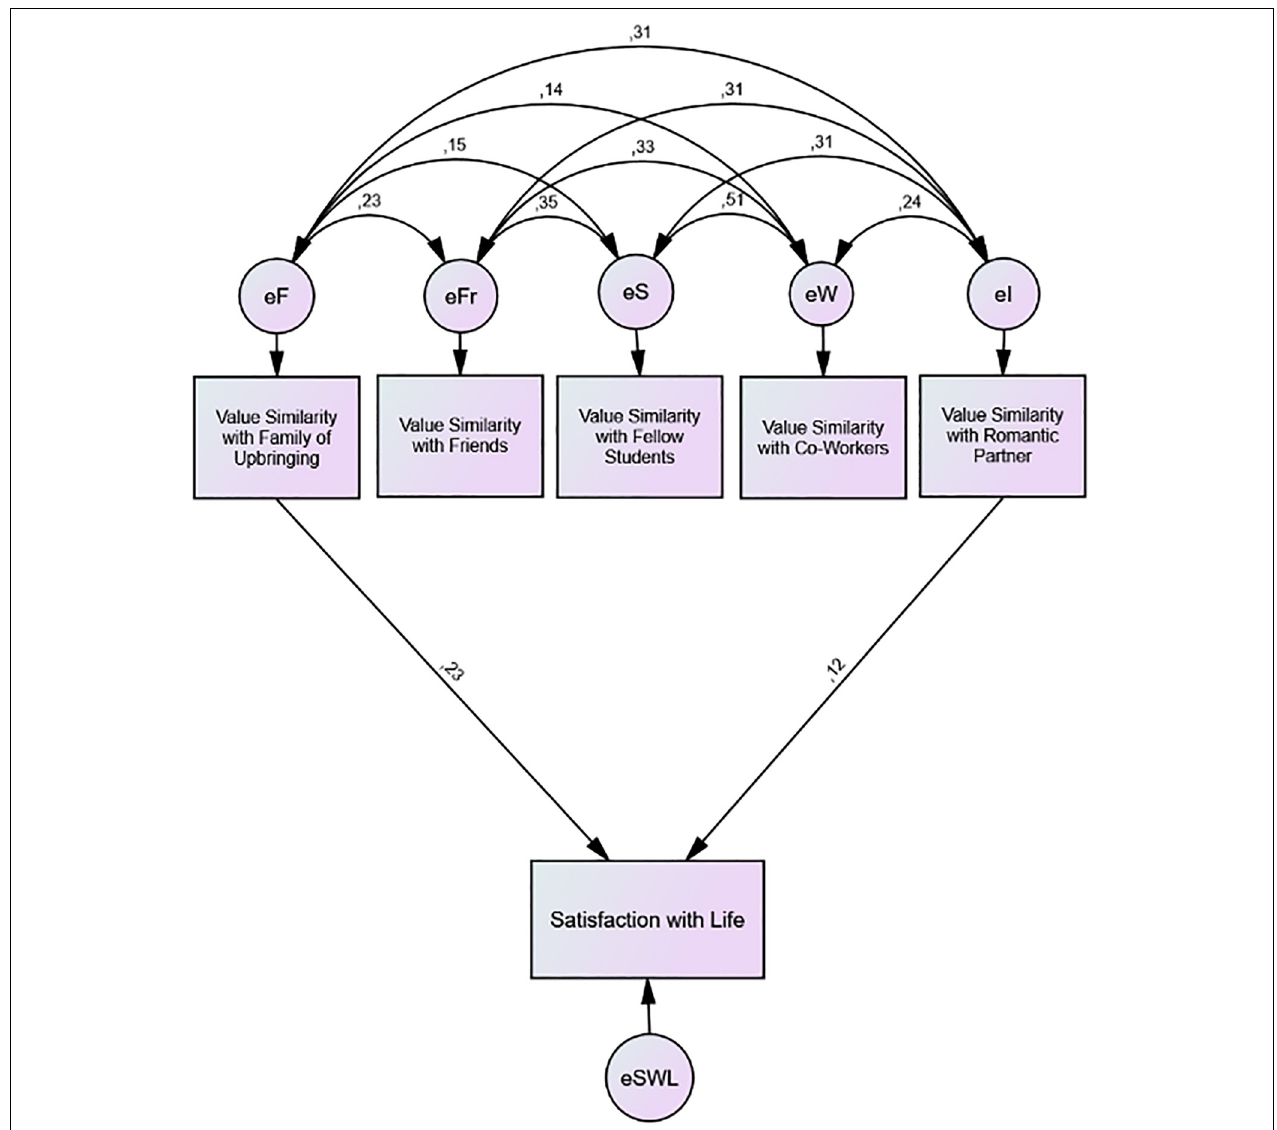
FIGURE 5 | Value similarity and well-being across